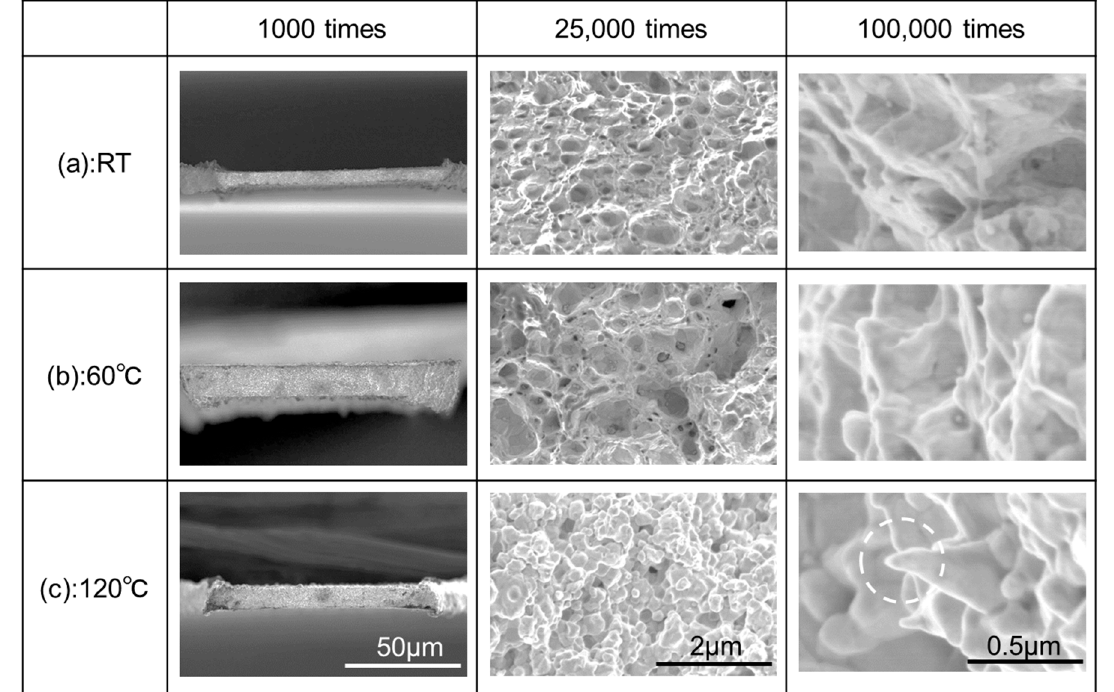
Figure 7. ( a – c ) Representative SEM images of s-Ag fracture surface together with the magnified images after tensile tests at RT, 60 °C, and 120 °C, respectively.